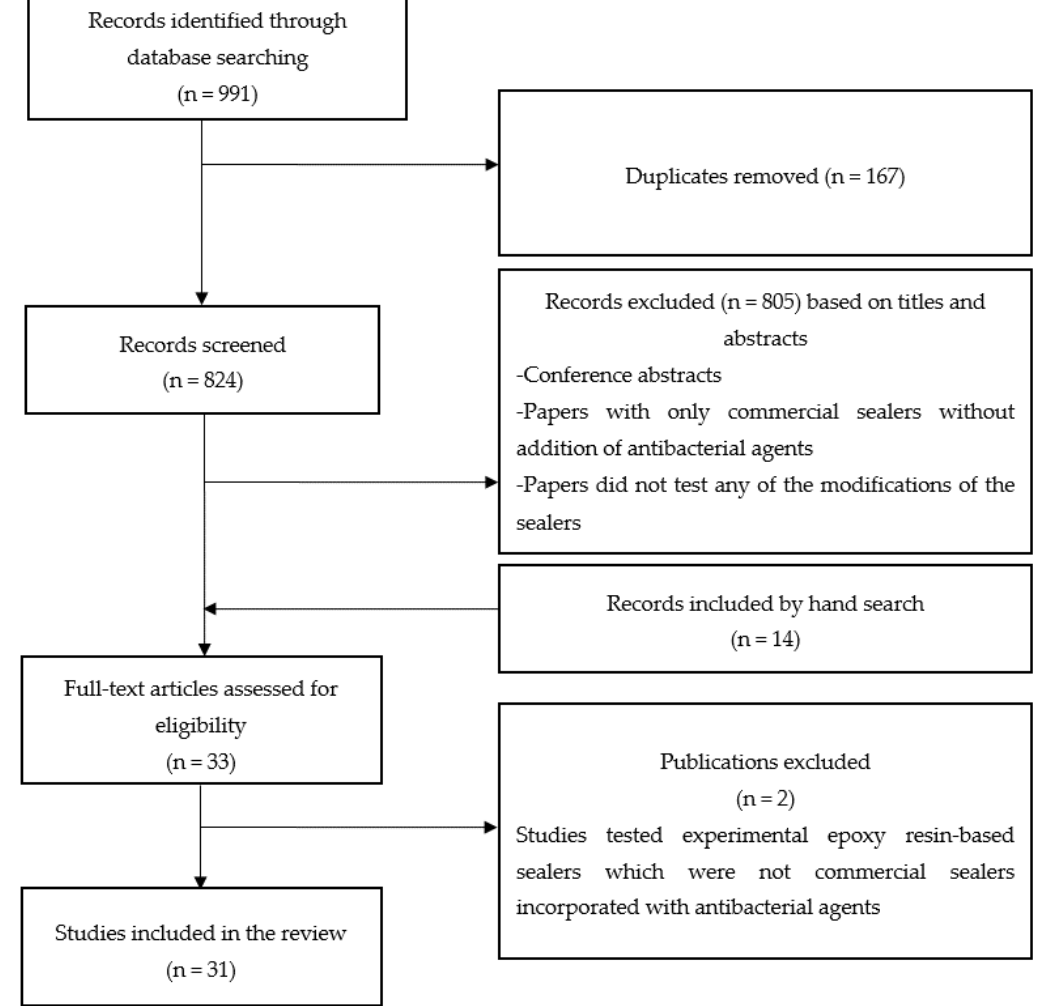
Figure 1. PRISMA (Preferred Reporting Items for Systematic reviews and Meta-Analyses) flowchart showing the search process.